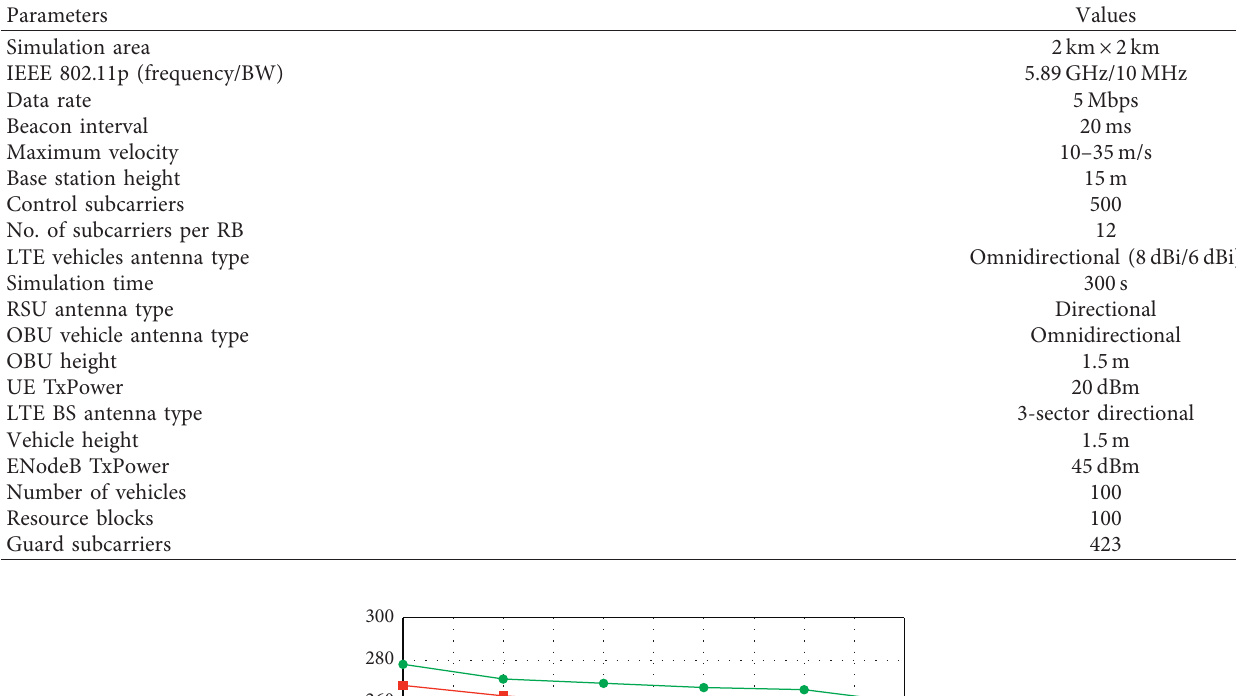
Table 2: Simulation parameter setting.